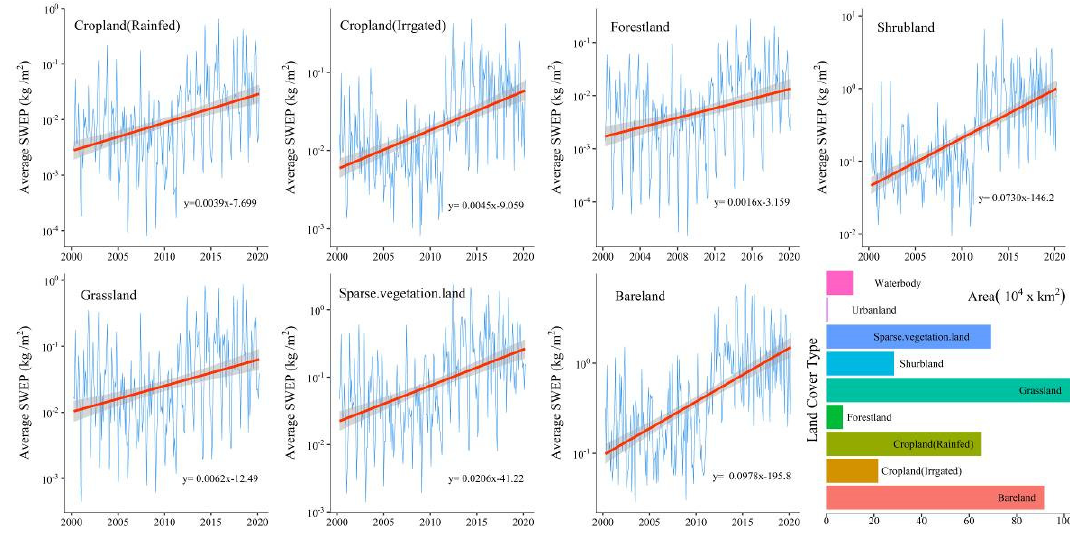
Figure 9. Monthly change of the average SWEP of different land cover types and the area of different land cover types across CA in 2018. Table 2. Soil wind erosion rate studies in CA and other regions with similar conditions.